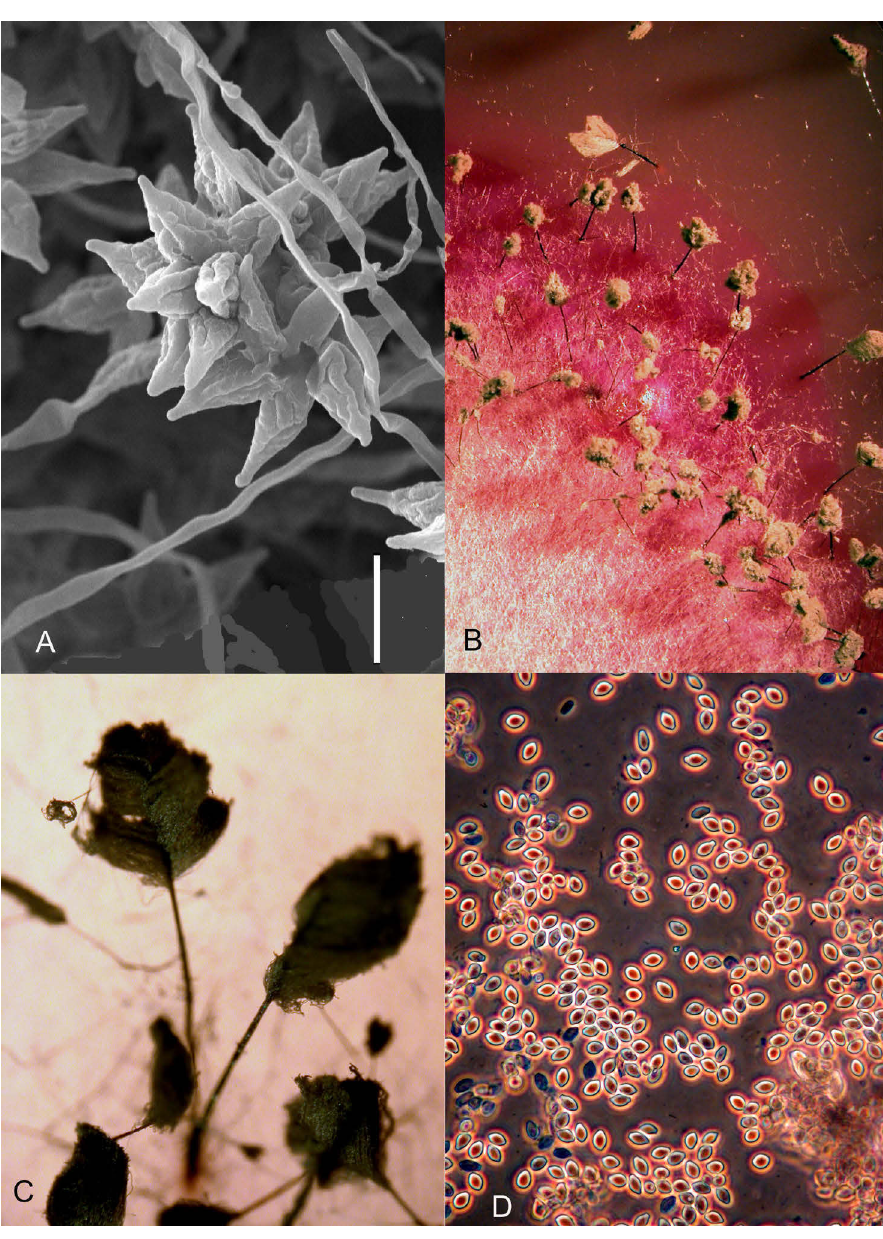
Fig. 2. Morphology of Cephalotrichum stemonitis and its synanamorph – Echinobotryum atrum : A – conidia of E. atrum ; scale bar = 10 µm; B – synnemata of C. stemonitis on DRBC medium; C – synnemata of C. stemonitis similar to feather; D – conidies of C. stemonitis